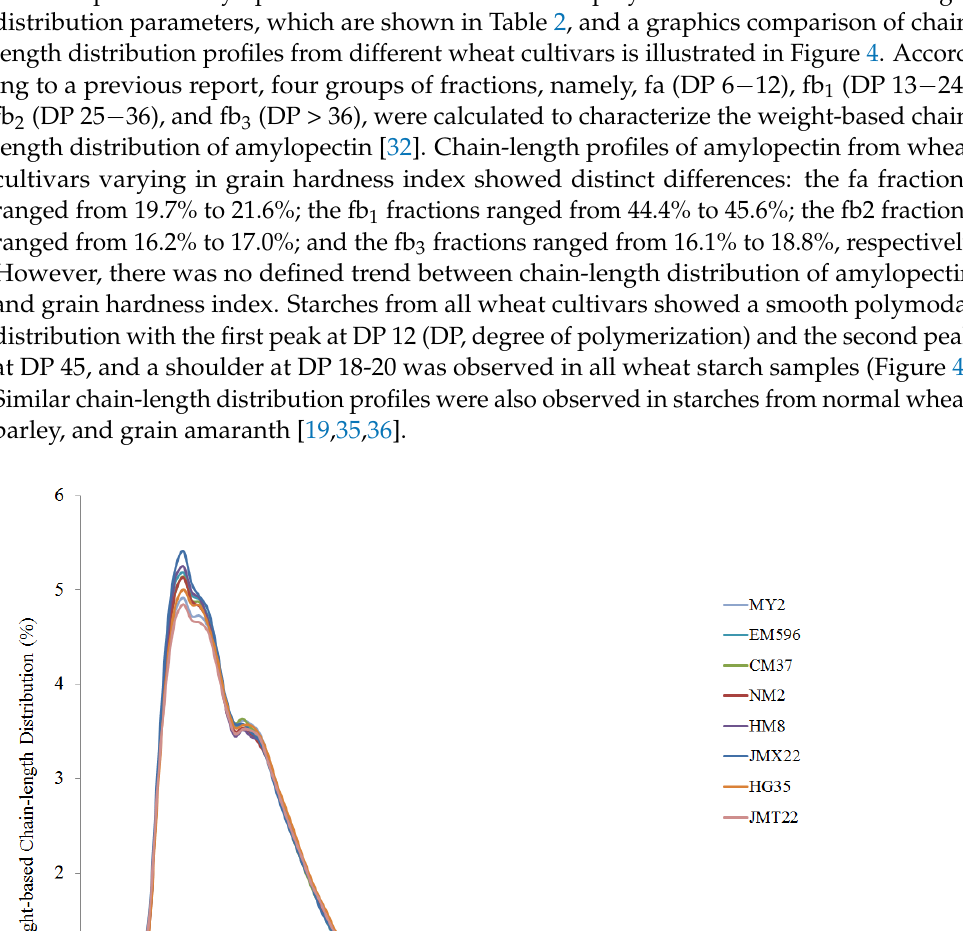
Figure 4. Chain-length profiles obtained by HPAEC of amylopectin from wheat varying in grain hardness.